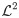
Biot’s equations—inverse modeling: PINN performance as function of training set size.This figure shows the estimated error dependency on the amount of training data, Ntr. (a) θ1, θ2, θ3, θ4, and θ5 and (b) u, v, and p. The error bars show mean and standard derivation (± 1 SD) based on 27 realizations. The reported error values of θ1, θ2, θ3, θ4, and θ5 are percentage errors while the relative L2 error is shown for u, v, and p. Note that there is no noise in this investigation.